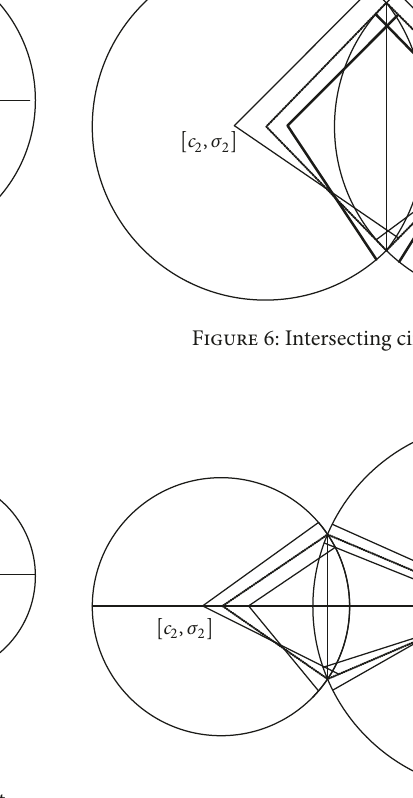
Figure 7: Intersecting circles of unequal